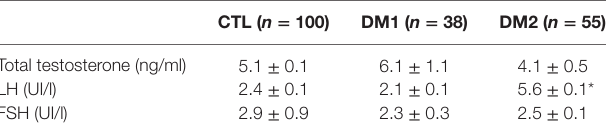
Table 4 | Hormone concentrations of patients with type 1 diabetes mellitus (DM1), type 2 diabetes mellitus (DM2), and the control (CTL) group.